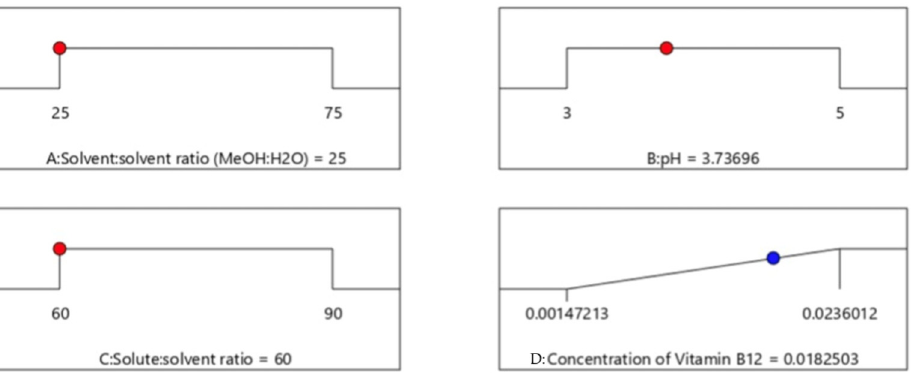
Figure 4. Desirability ramp for numerical optimization of independent variable, solvent:solvent ra- tio, pH and solute:solvent ration for the concentration of CN-Cbl of ODU sample. A: solvent:solvent ratio (MeOH:H 2 O); B: pH; C: solvent:solvent ratio; D: concentration of CN-Cbl.